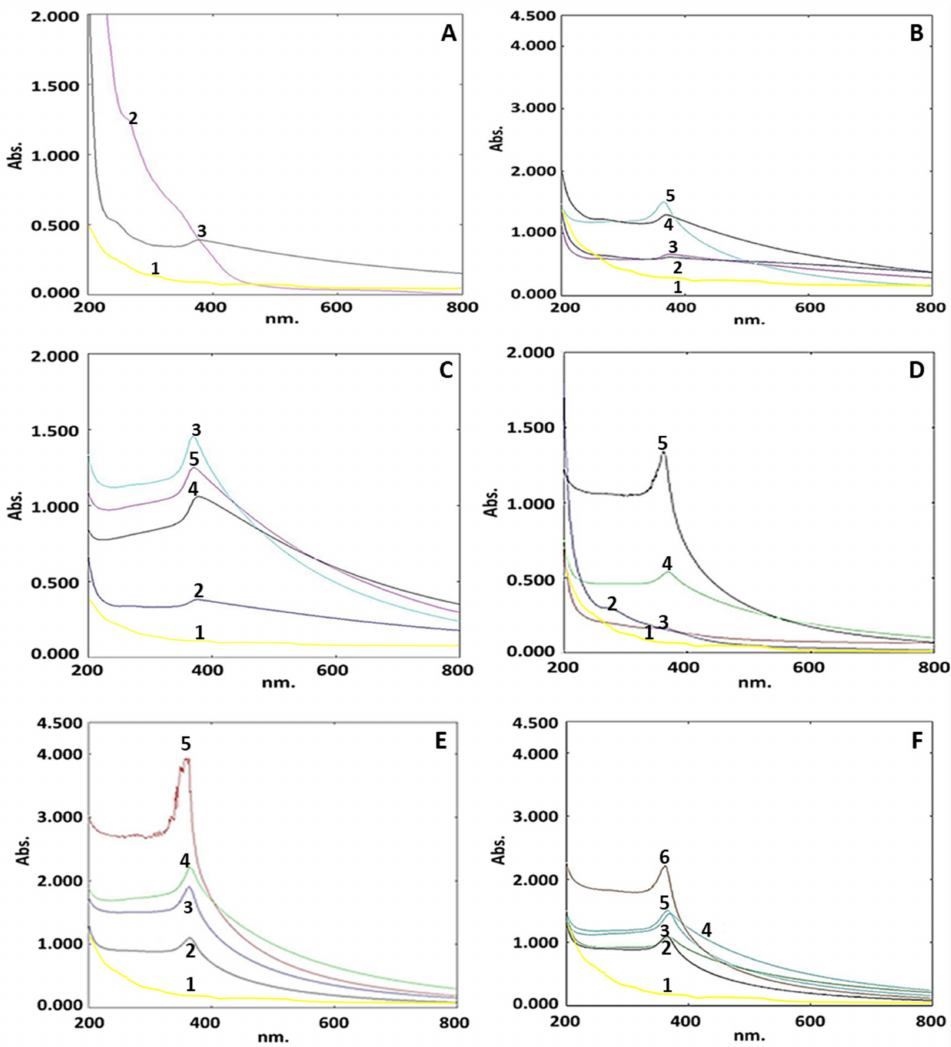
Figure 1. ( A ) UV–visible spectra for the ZnPs synthesis reaction mixture (with 1.5 g zinc acetate, 5 mL APLAE, pH 12, and at 25 ◦ C) and pure APLAE corresponding to curves 2 and 3, respectively. ( B ) Optimization of ZnPs reaction mixture for different concentrations of zinc acetate solution (0.5, 1.0, 1.5, and 2.0 g corresponding to curves 2, 3, 4, and 5, respectively). ( C ) Optimization of ZnPs reaction mixture for different volumetric concentrations of APLAE (2, 4, 5, and 8 mL corresponding to curves 2, 3, 4, and 5, respectively). ( D ) Optimization of ZnPs reaction mixture for pH (4, 7, 8, and 12 corresponding to curves 2, 3, 4, and 5, respectively). ( E ) Optimization of ZnPs reaction mixture for temperature (4 ◦ C, room temperature, 60 ◦ C and 80 ◦ C corresponding to curves 2, 3, 4, and 5). ( F ) Stability of ZnPs reaction mixture (for 2 h, 1 d, 5 d, 10 d, and 30 d corresponding to curves 2, 3, 4, 5, and 6). In all spectra, curve 1 represents the pure zinc acetate